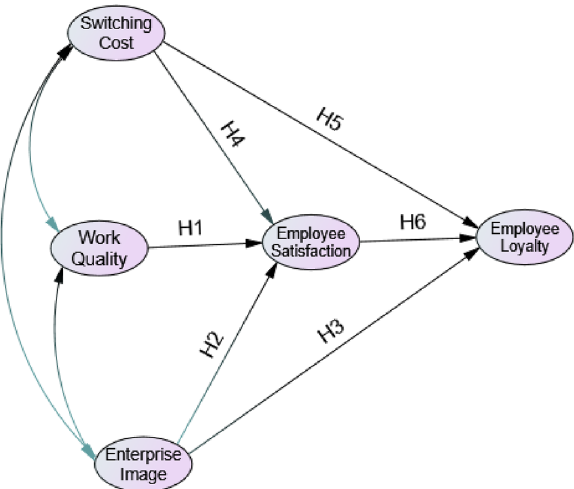
Figure 1. Conceptual